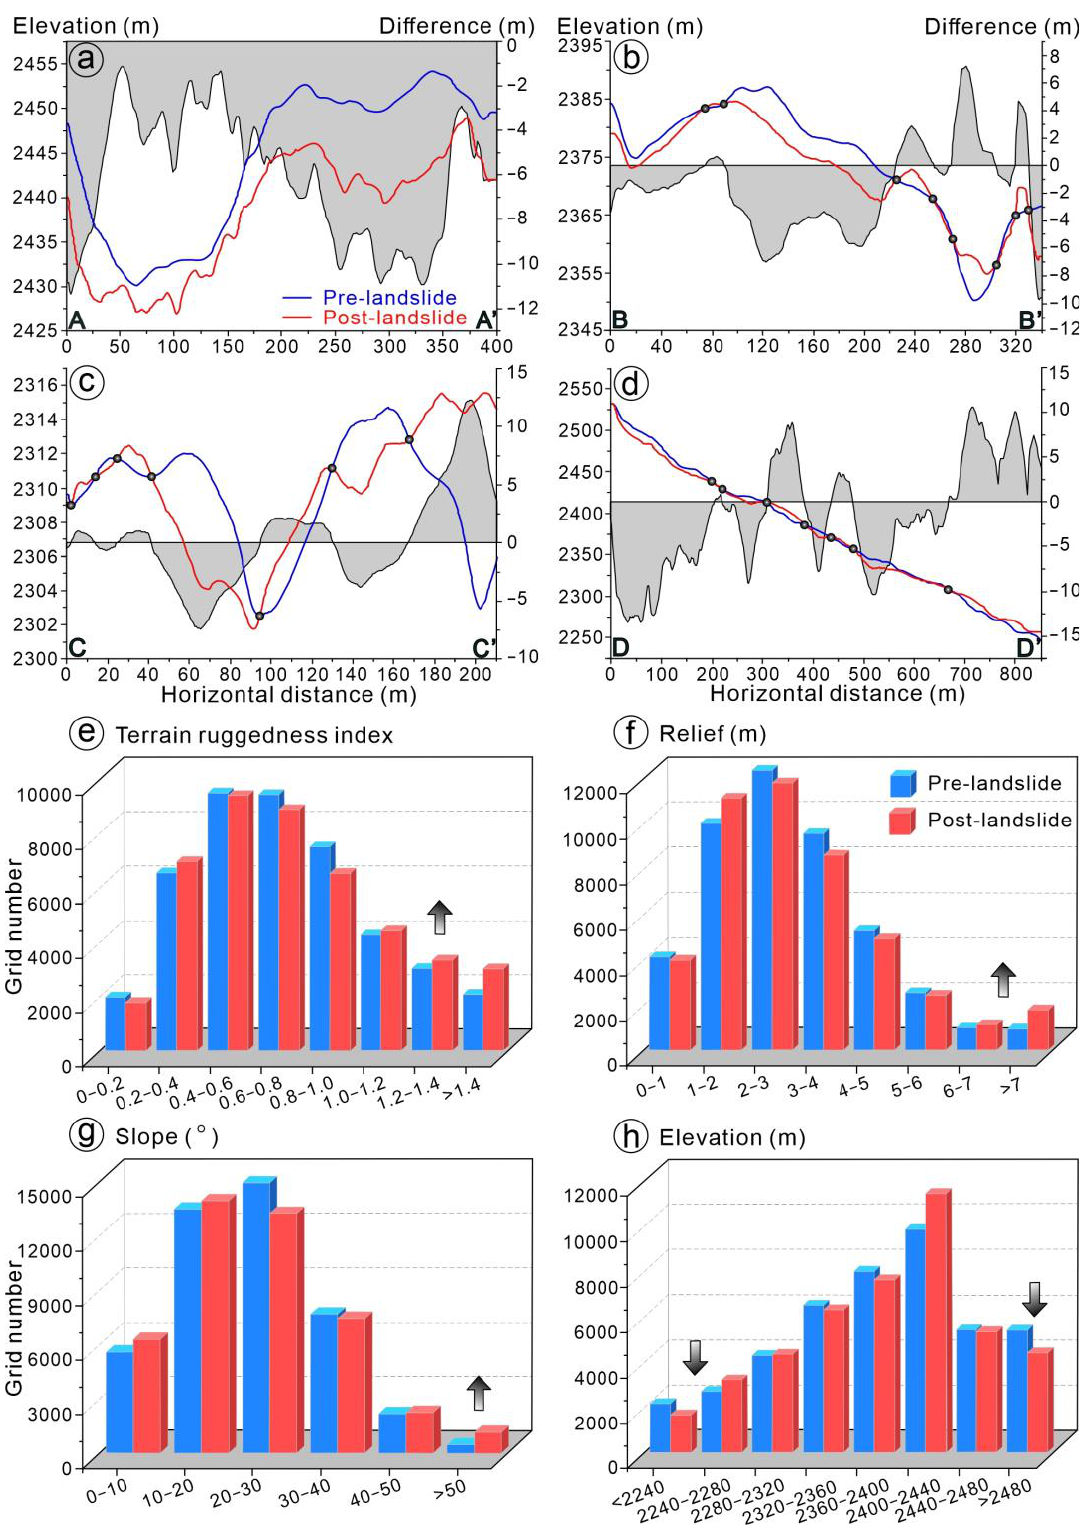
Figure 5. Topographic changes before and after the landslide. ( a – d ) Elevation in the profiles (Figure 4b). ( e – h ) Topographic factors. Table 2. Topographic changes in the landslide in terms of area, volume and thickness. Landslide Parameters Surface Lowering